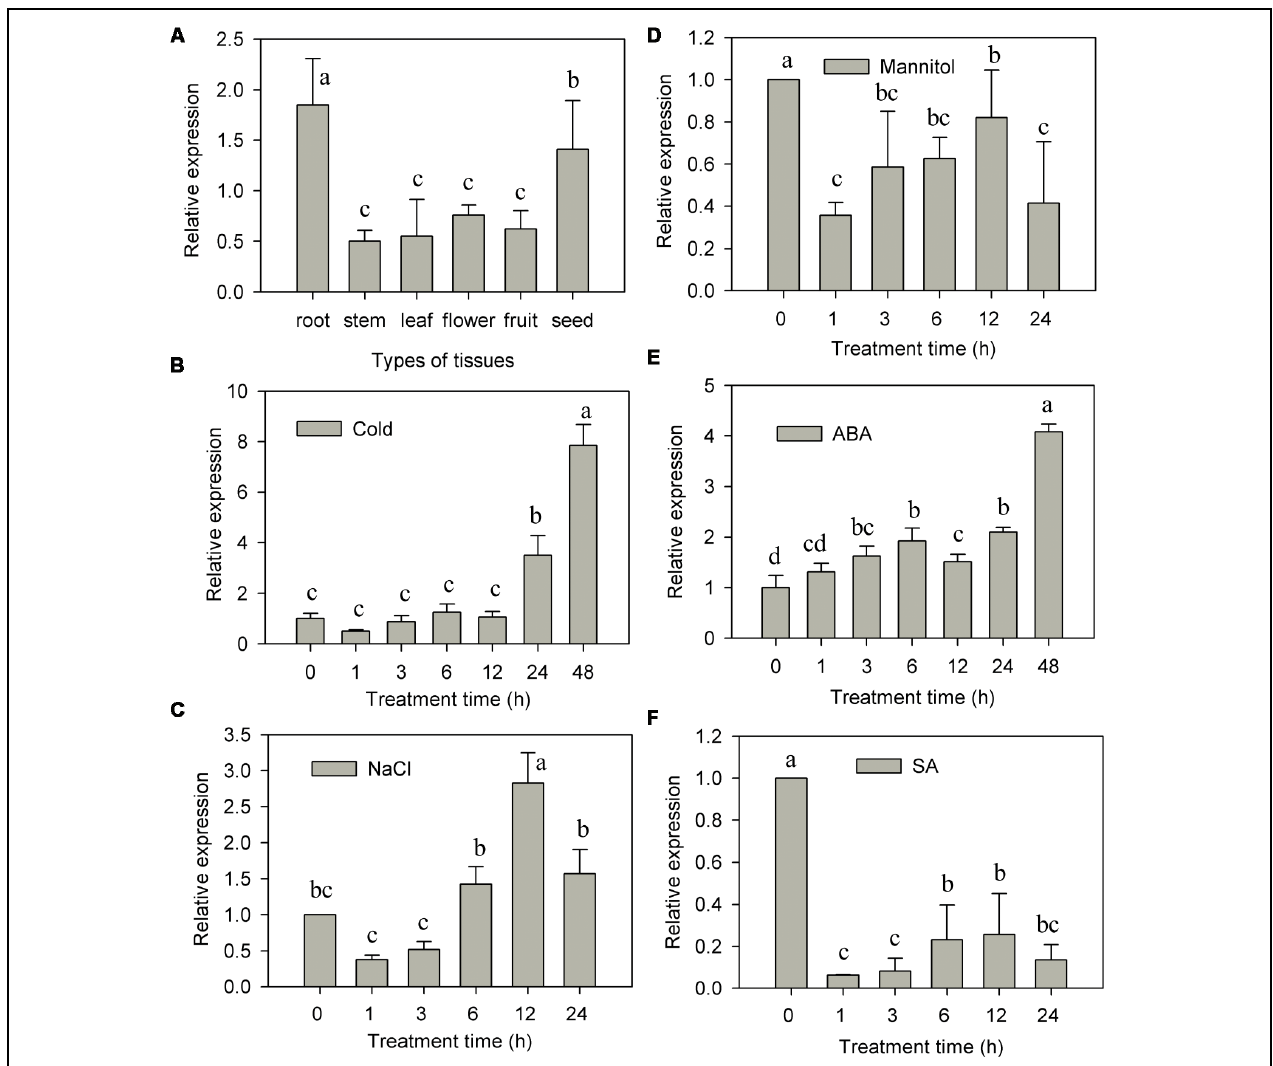
FIGURE 3 | CaNAC2 expression both in tissue and in response to stress and exogenous hormones. (A) Tissue specific expression of CaNAC2 ; (B) The pepper seedlings were exposed to cold stress (6 ◦ C), (C) salt stress (300 mM NaCl) and (D) osmotic stress (300 mM mannitol) for the indicated times; the pepper seedlings were sprayed with exogenous ABA (E) and SA (F) . Pepper Ca Ubi3 gene was used as an internal control for qRT-PCR. The transcript level of CaNAC2 at 0 h is used as control (quantities of calibrator) and was assumed as 1. Results are the mean ± SE. Different letters indicate that the mean values are different by the Tukey HSD test ( p ≤ 0.05). Each mean was compared with all the other mean values shown in the same